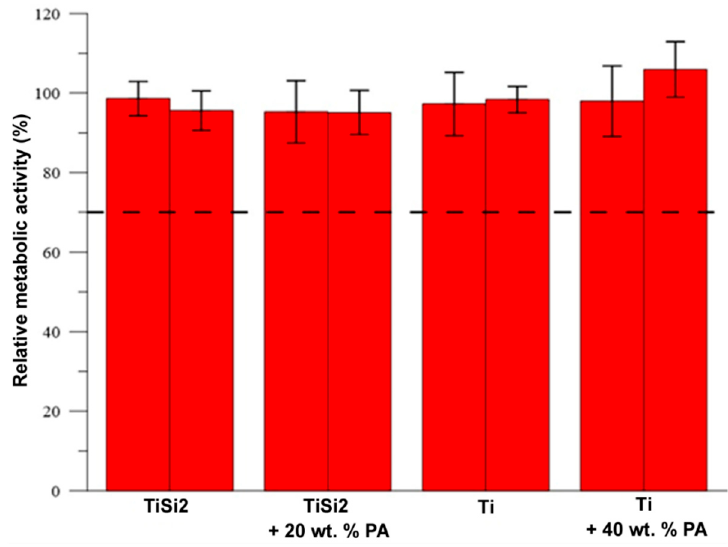
Figure 14. Metabolic activity of L929 cells after 24 h incubation with the extracts.